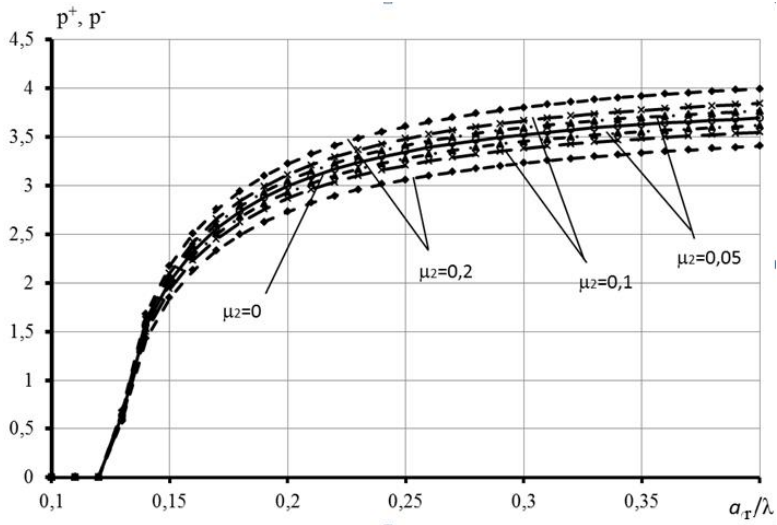
Fig. 3. Waves slowing coeffitients on parameter а r /  functions at different values of magnetization  2.